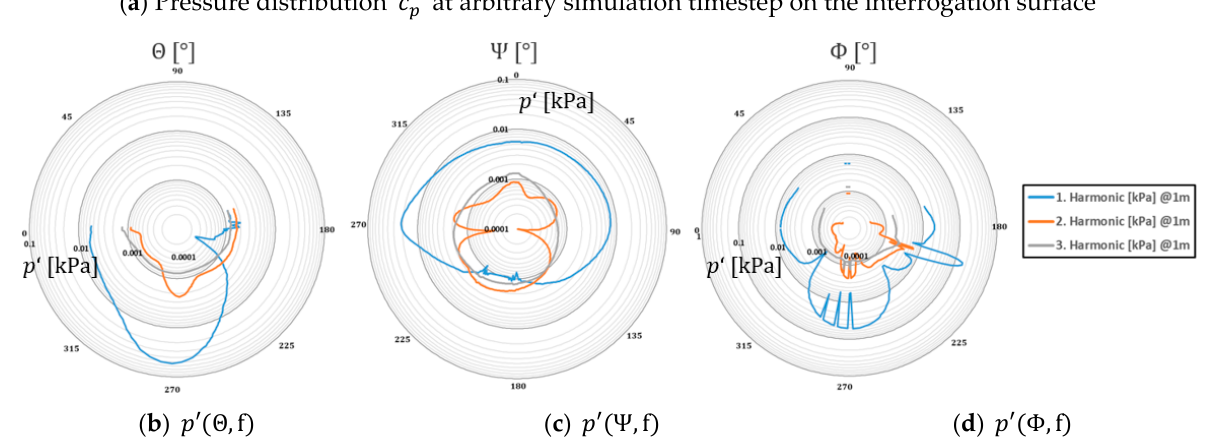
Figure 27. Directivity of harmonic frequencies on the passive rectangular box around propeller-hull combination.